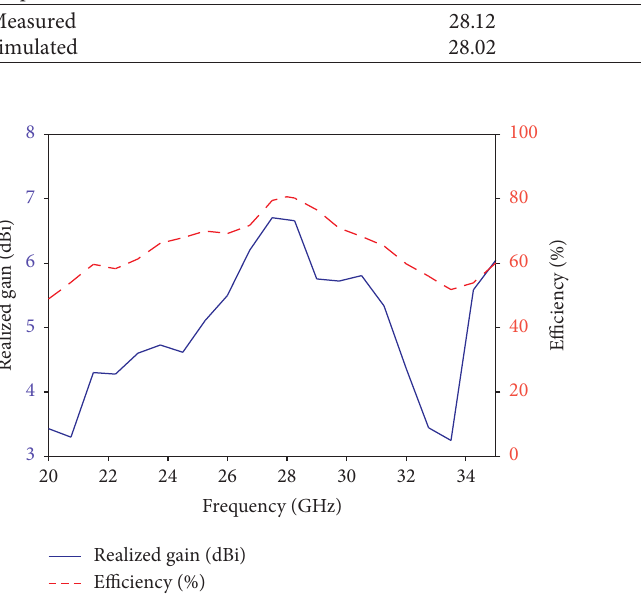
Figure 13: Realized gain and total efficiency of the proposed MIMO antenna.